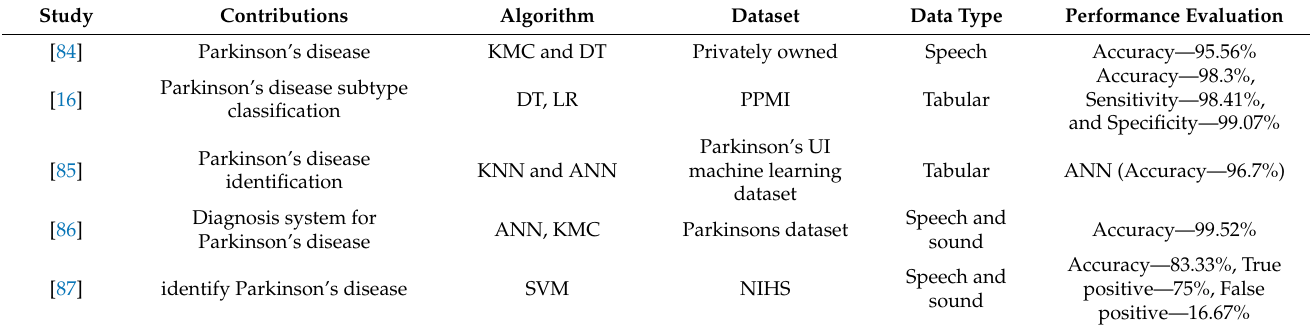
Table 7. Referenced literature that considered machine-learning-based Parkinson’s disease